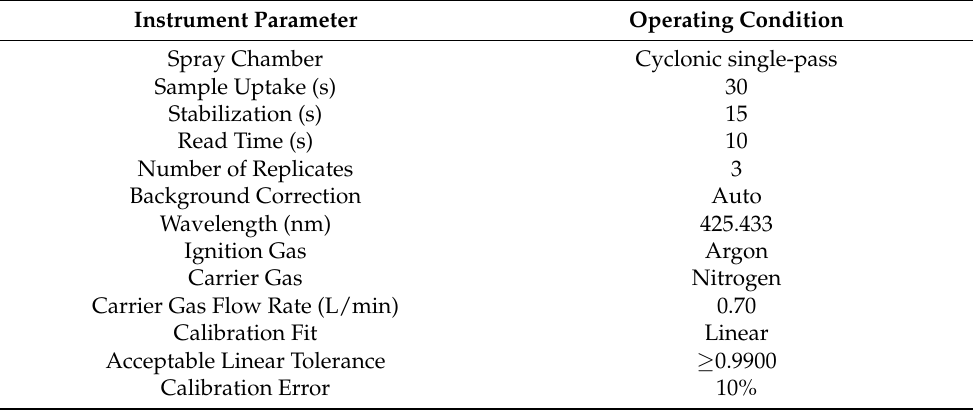
Table 7. MP-AES operating conditions for the analysis of chromium